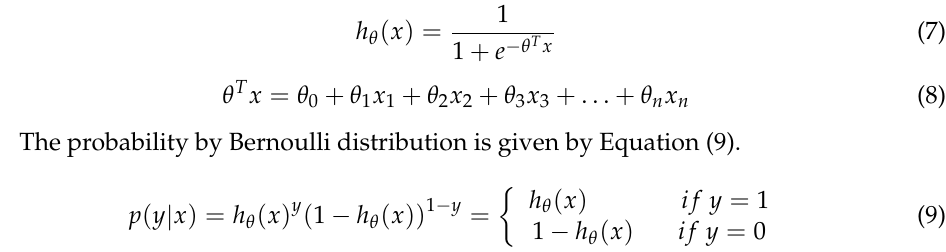
Figure 3. LSTM model with the many-to-many structure.